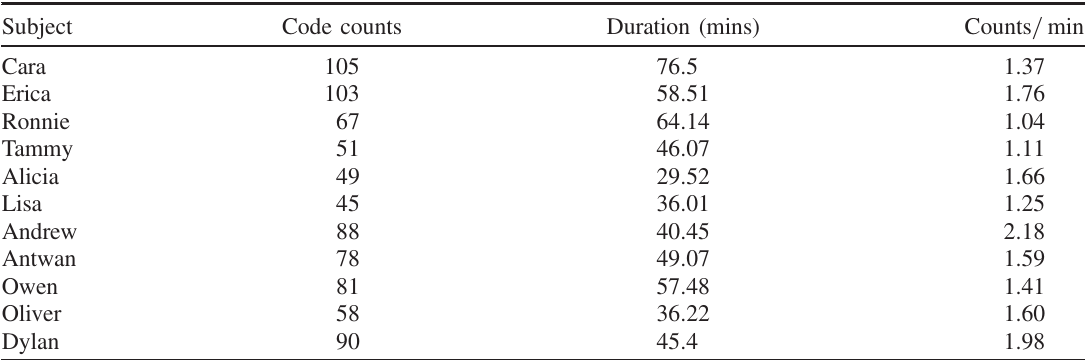
TABLE III. The code counts, duration, and code count per minute ratio for each interview in the 11 person